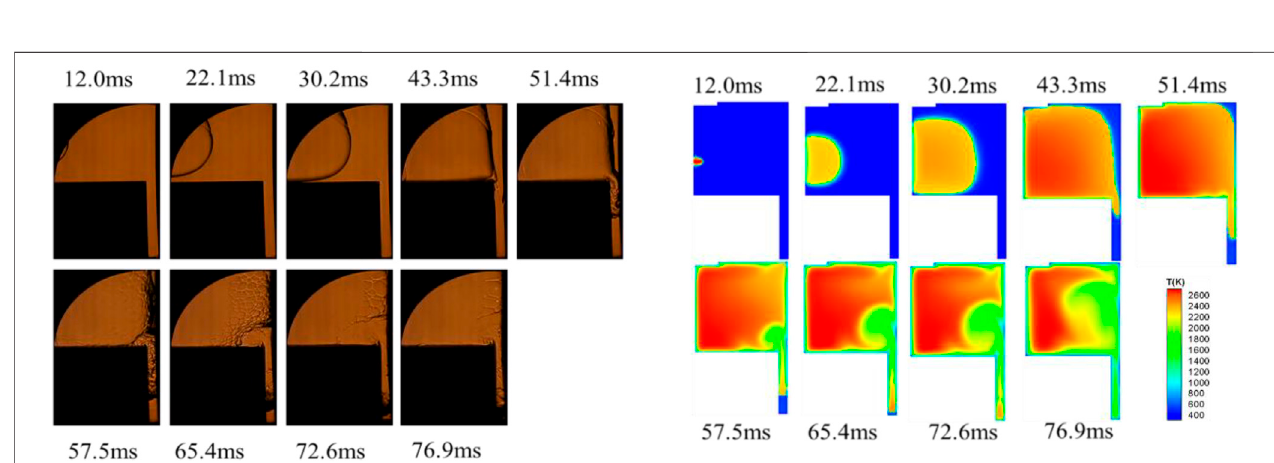
FIGURE 7 | Experimental observation and numerical simulation of methane fl ame propagation under wet wall condition at an initial pressure of 0.2 MPa.